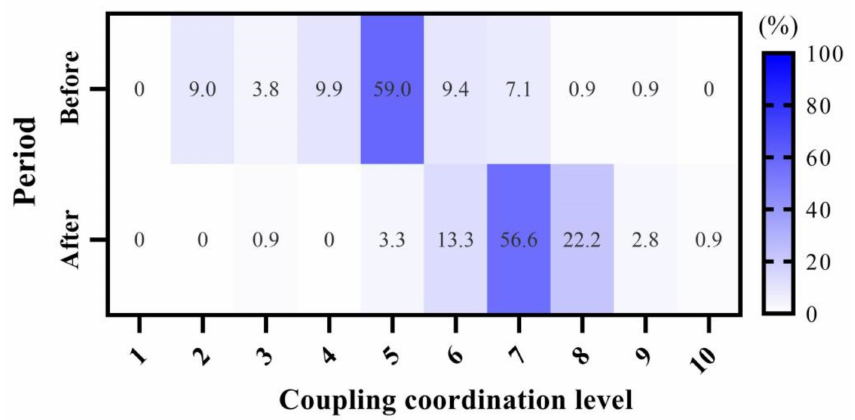
Figure 6. Distribution of coupling coordination levels.